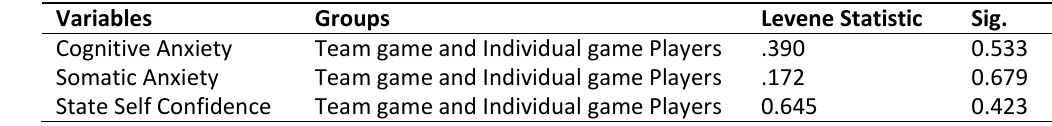
Table 2. Mean Values and One- Way ANOVA of Cognitive Anxiety, Somatic Anxiety and Self-Confidence between Team Sport and Individual Sport Athletes in Iran